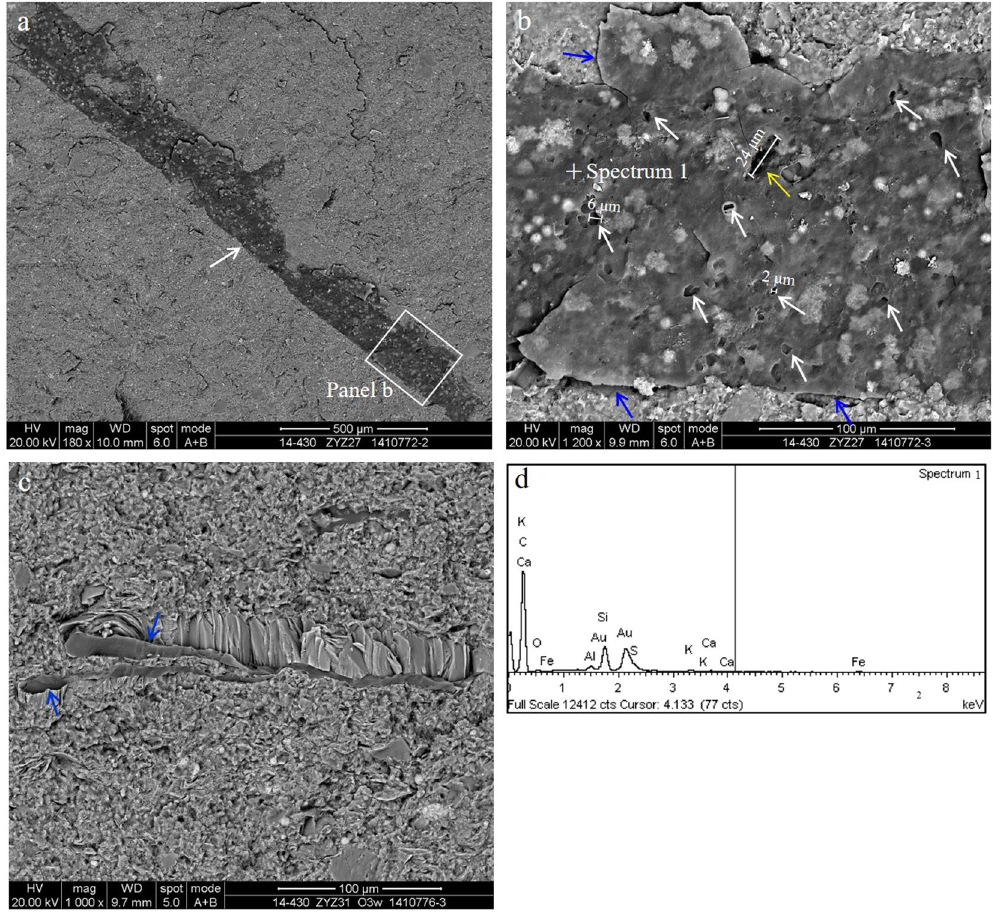
Figure 8. The graptolite and related pores. ( a ) Overview of the profile, the graptolite (white arrows) is developed on the bedding surface of the Longmaxi Formation in well Jiaoye 1 (2380.45 m). ( b ) Graptolite, amplification of panel (b) in Figure a. Pores in graptolite, small pores (white arrows), large pores (yellow arrows) and shrinkage joint between graptolite and minerals (blue arrows). ( c ) Graptolite of the Wufeng Formation in well Jiaoye 1 (2415.19 m). Shrinkage joint between graptolite and minerals (blue arrows). ( d ) The energy spectrum of graptolite is shown in ( b ).